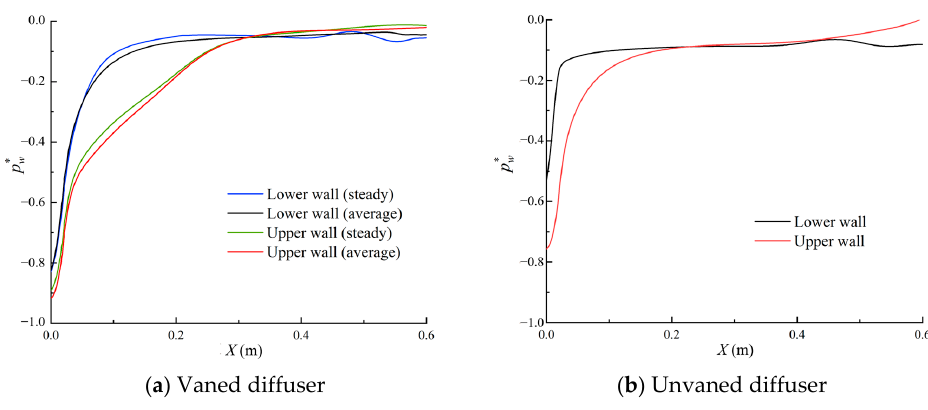
Figure 12. Time-averaged wall-pressure distributions.